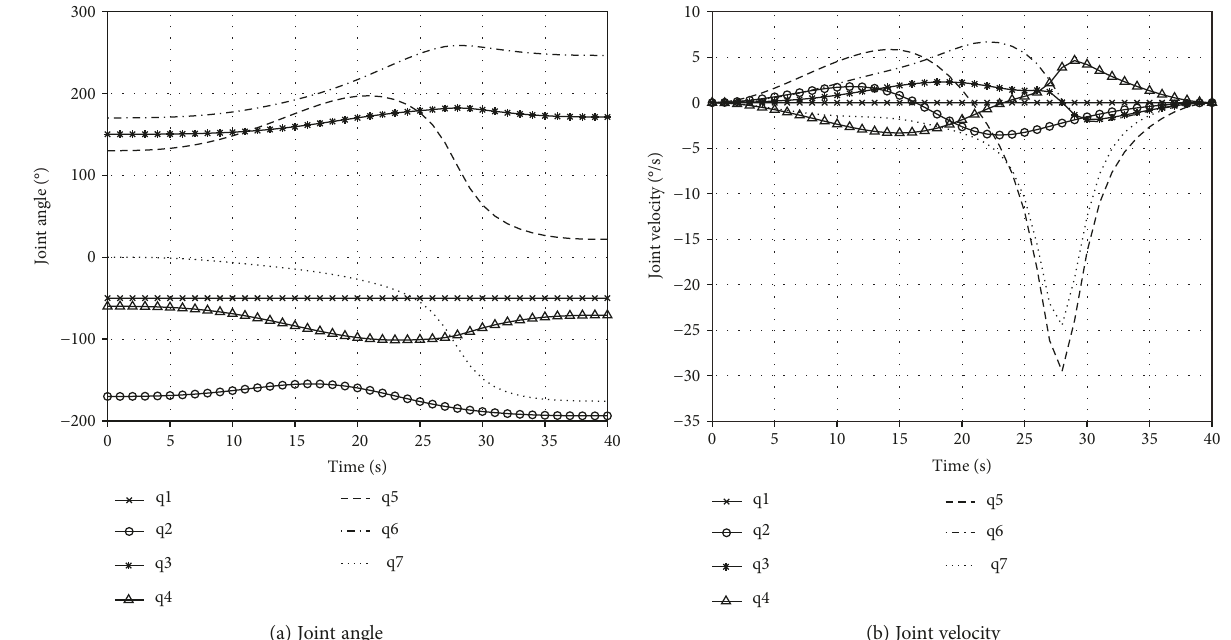
Figure 5: The variations of joint angle and velocity with execution of the trajectory tracking task.